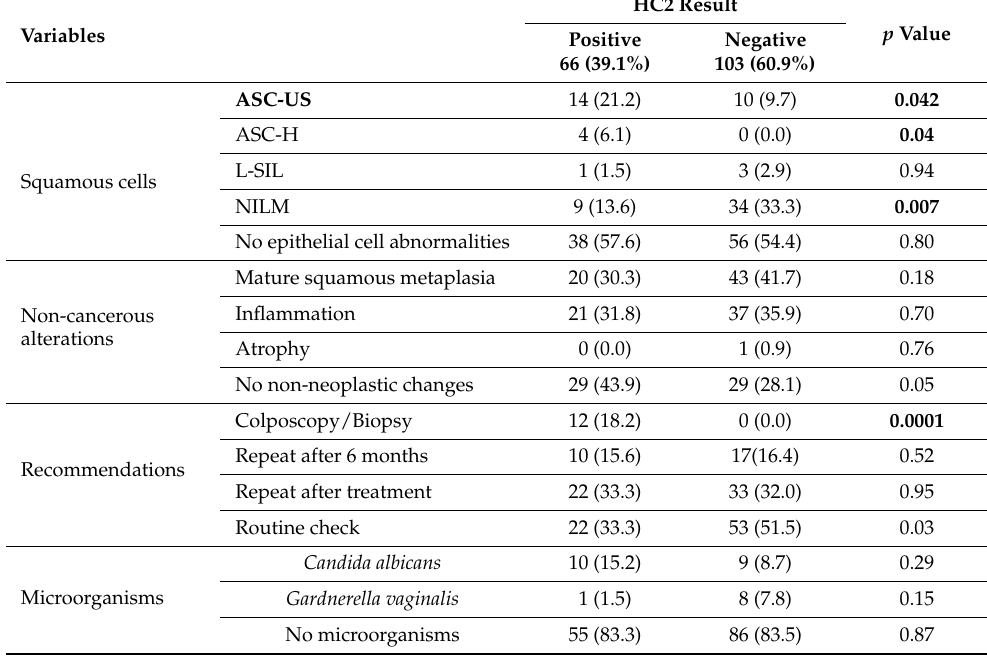
Table 1. The HC2 results in correlation with the Pap test